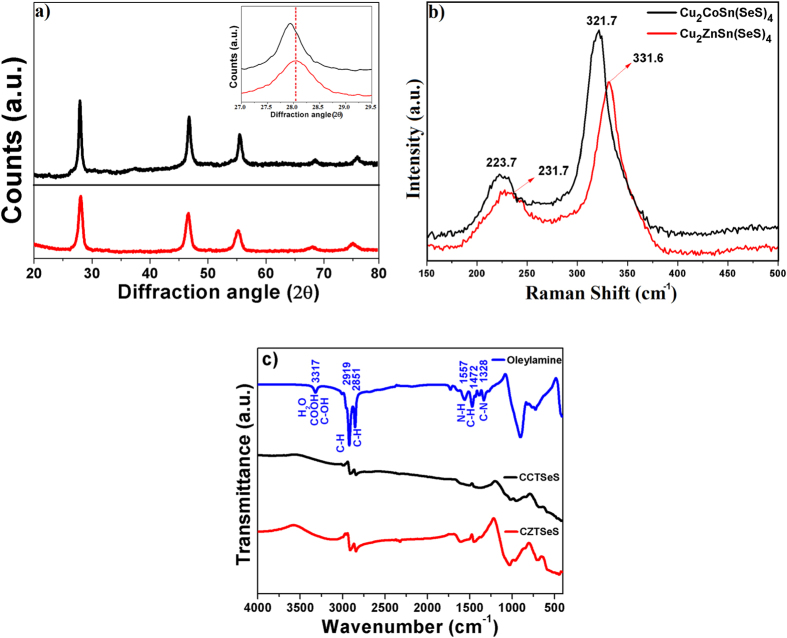
(a) XRD Patterns and (b) Raman spectrums of Cu2CoSn(SeS)4 and Cu2ZnSn(SeS)4 nanocrystals at room temperature. (c) FTIR spectra of oleylamine and both nanocrystals.